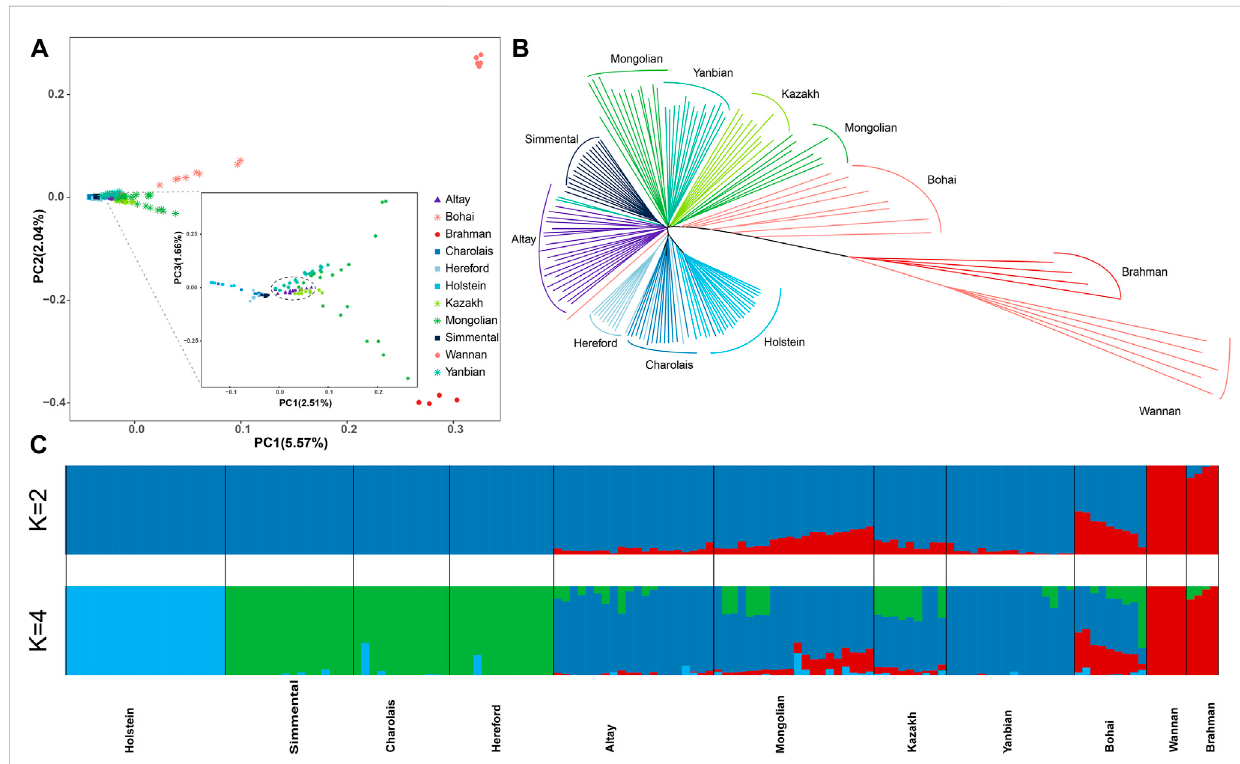
FIGURE 2 Population structure and relationships of Altay white-headed Cattle. (A) The plot of principal component analysis (PCA) results showing PC1 versus PC2. (B) Neighbor-joining phylogenetictree constructed using whole-genomeSNP data. (C) Model-based clustering of cattle breedsusing ADMIXTURE with K = 4. Colours re fl ect the different cattle